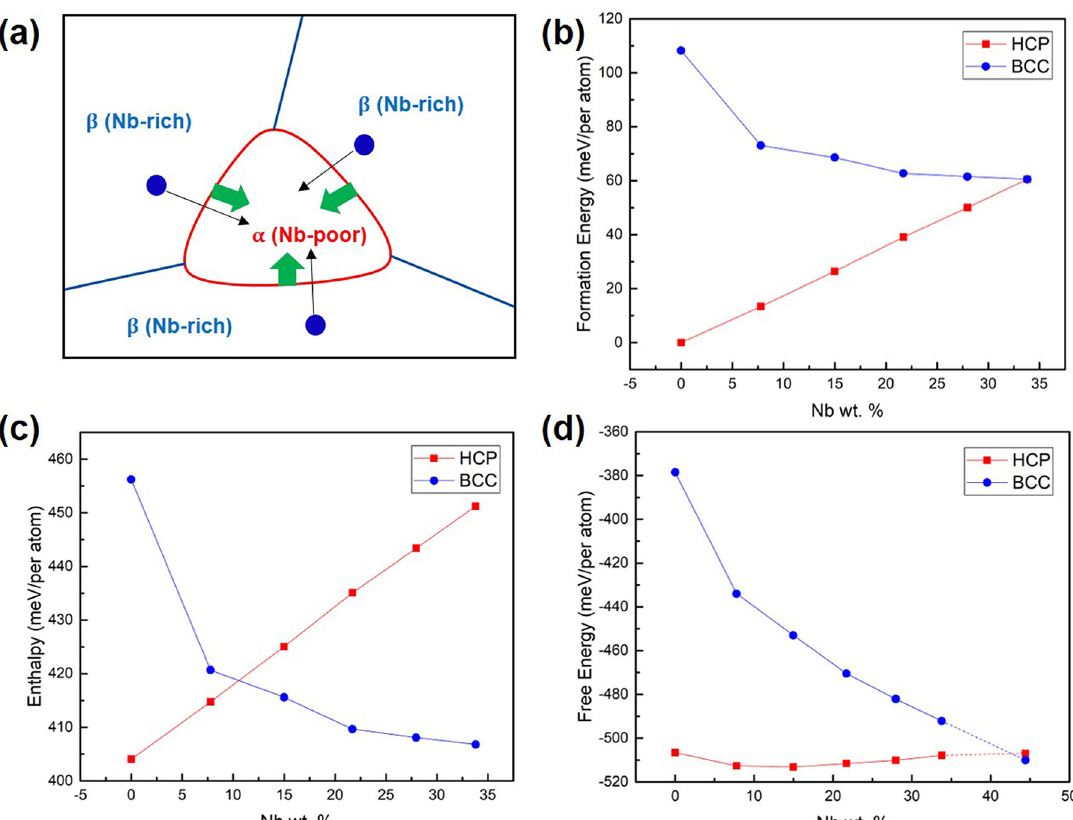
Figure 8 . The Schematic diagram of: (a) the diffusion of niobium from BCC to HCP phase, (b) the phase transformation from HCP to BCC phase after the diffusion, (c) the relationship between Nb concentration and formation energy of HCP and BCC phase at 0 K, (d) the relationship between Nb concentration and the enthalpy of HCP and BCC phase at 1155 K, and (e) the relationship between Nb concentration and free energy of HCP and BCC phase at 1155